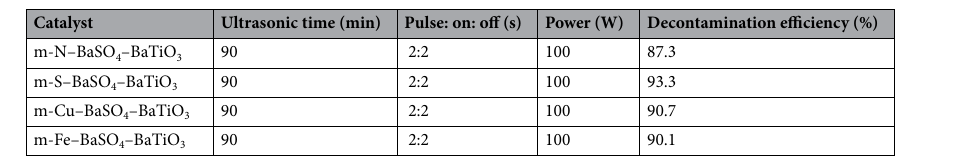
Table 5. Effect of sucrose on piezocatalytic activity of doped BaTiO 3 to degrade AB113.